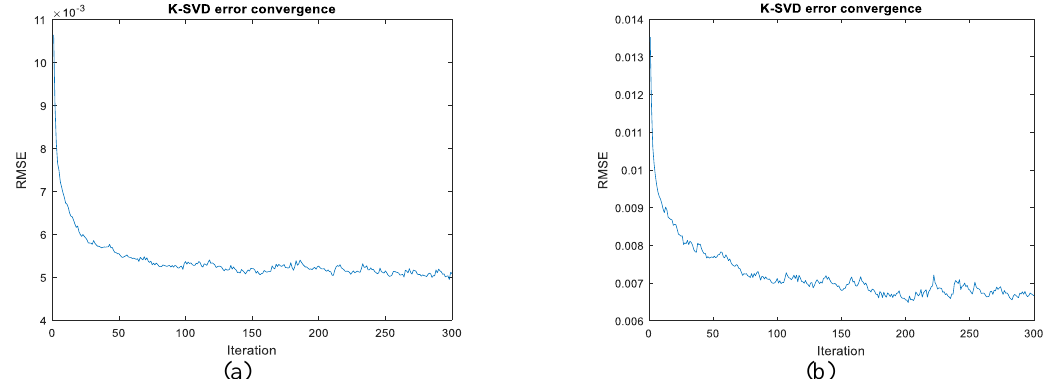
Figure 3. The convergence plot of the proposed dictionary learning algorithm using the HOG features: a) for face data, b) for non-face